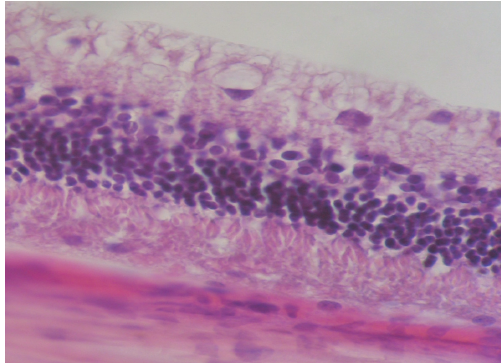
Figure 1: Shortly after suction 20 seconds, every layer of rabbit retina is in order (HE ×